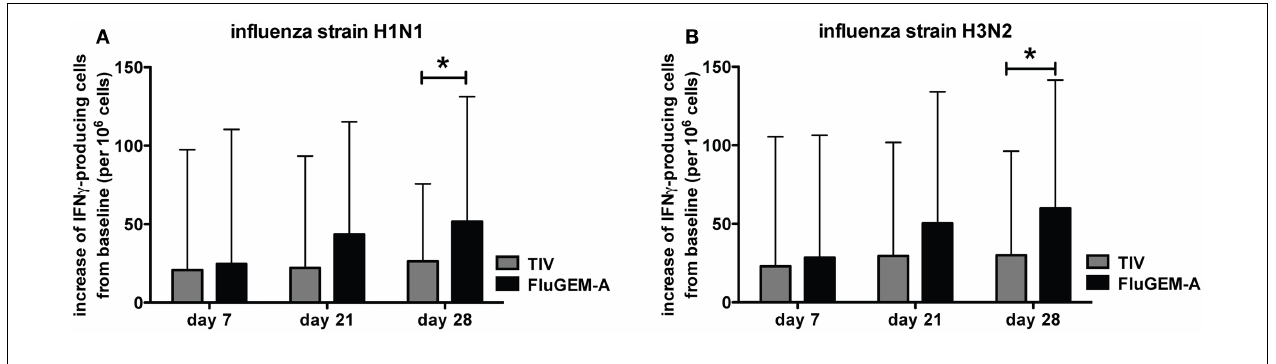
ELISPOT assay. Results are presented as a mean increase from a baseline (number of specific cells measured on day 0 per 10 6 cells) with 95% confidence interval depicted. * p < 0.05; two-tailed Student t-